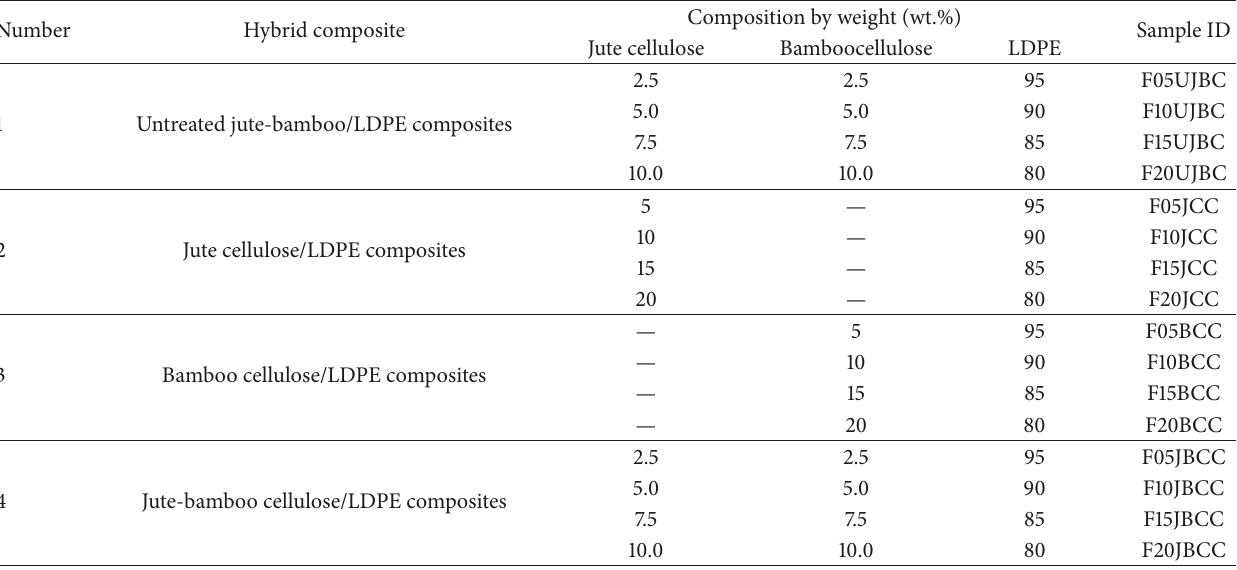
Table 1: Hybrid composite by weight